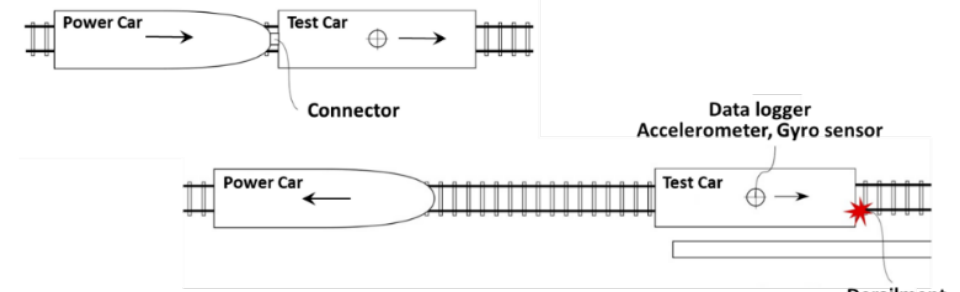
Figure 6. Concept of the push system.